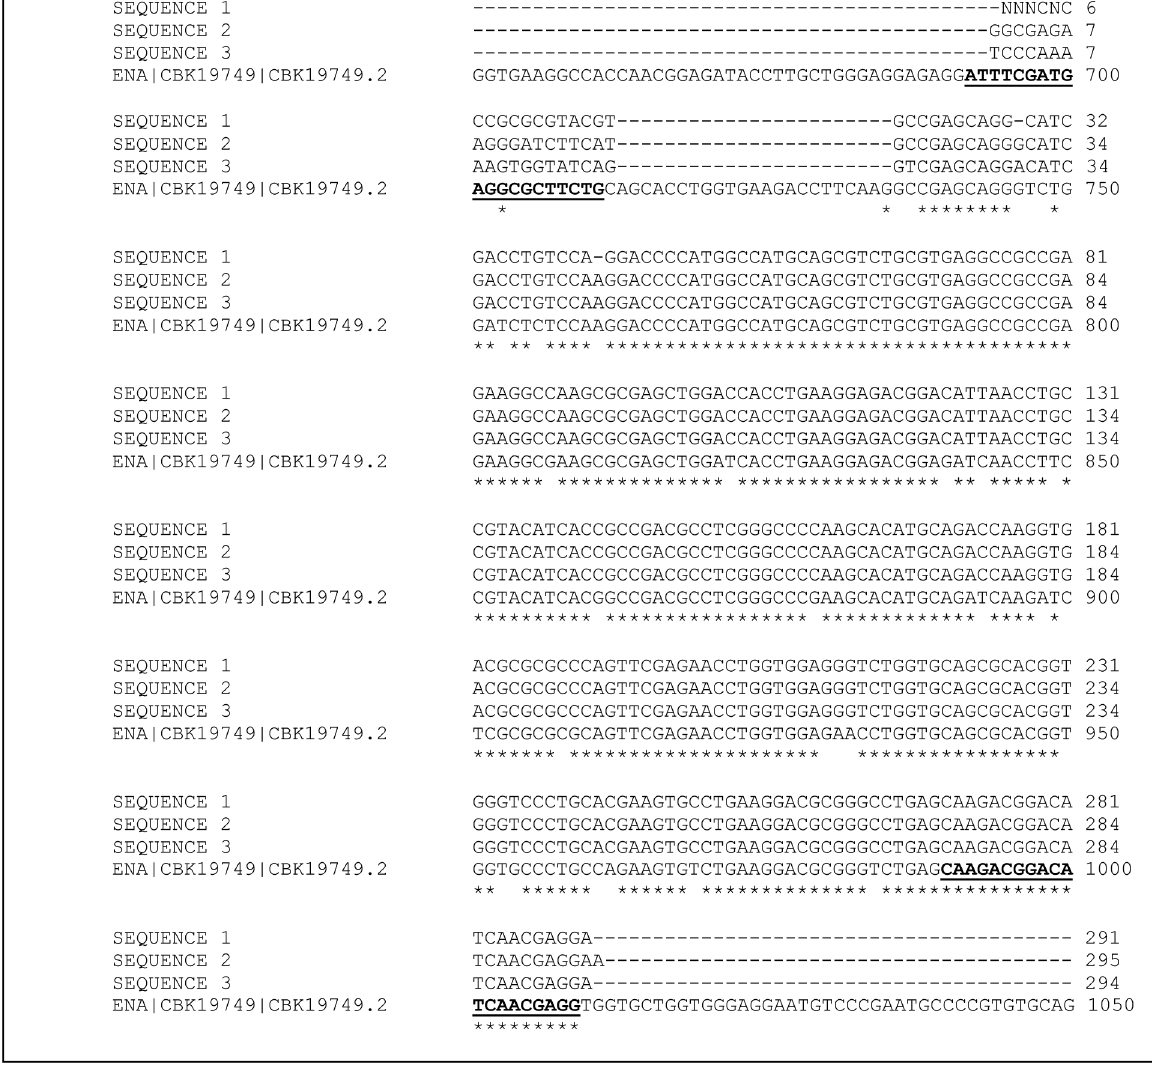
Figure 6. ClustalW2 multiple sequence alignment of the target sequence Blastocystissp. heat shock protein 70. Three random isolates of Blastocystis sp . was used. Primers (HSP70_F and HSP70_R) are indicated in bold and